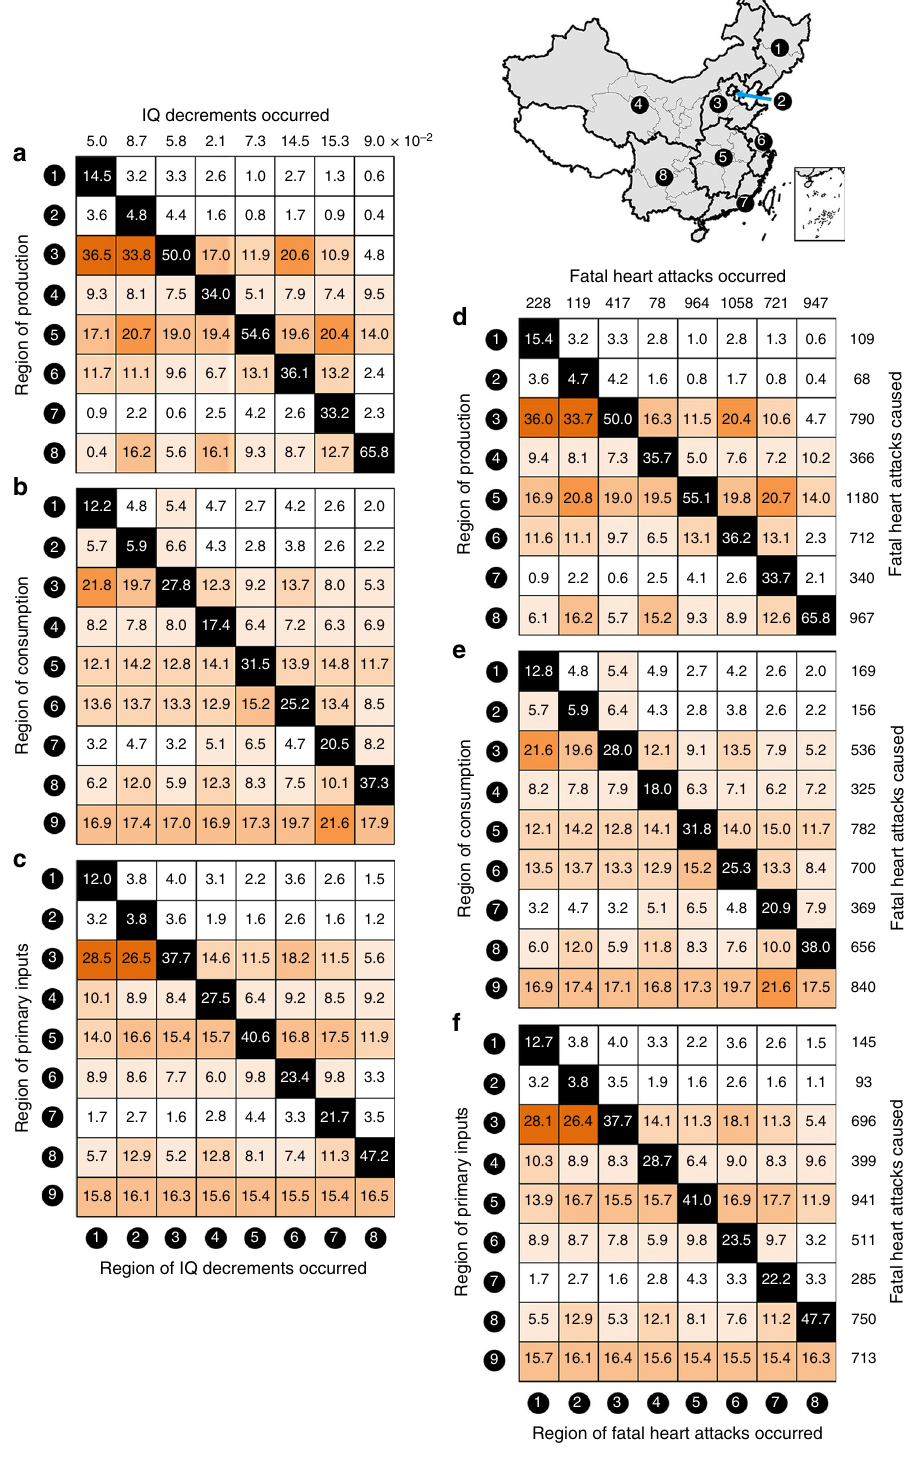
Fig. 3 Composition of attributable per-foetus intelligence quotient (IQ) decrements and fatal heart attacks in a given Chinese region. The composition in a given region results from anthropogenic mercury (Hg) emissions discharged by production activities ( a , d ), induced by fi nal consumption ( b , e ), and enabled by primary inputs ( c , f ) of local and external regions. a – c The results for IQ decrements and d – f the results for fatal heart attacks. Each cell in the grid shows the fraction of the health risk (%) of the column region caused by the production, fi nal consumption, and primary inputs of the row region. The total points of per-foetus IQ decrements that occur in each region are shown at the top of a , and the total deaths from fatal heart attacks that occur in each region are shown at the top of d . The total deaths from fatal heart attacks caused by each region are also shown on the right of d – f . Regions 1 to 9 represent the Northeast, Beijing-Tianjin region, North, Northwest, Central, Central Coast, South Coast, Southwest, and Int ’ l exports/imports (see Supplementary Fig. 3 for regional de fi nitions). A black-coloured cell in a region re fl ects the fraction of health risks in the region caused by local activities. In other cells, darker orange cells indicate higher fractions